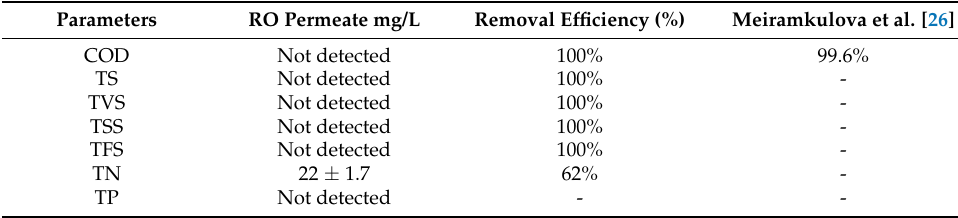
Table 9. RO permeate